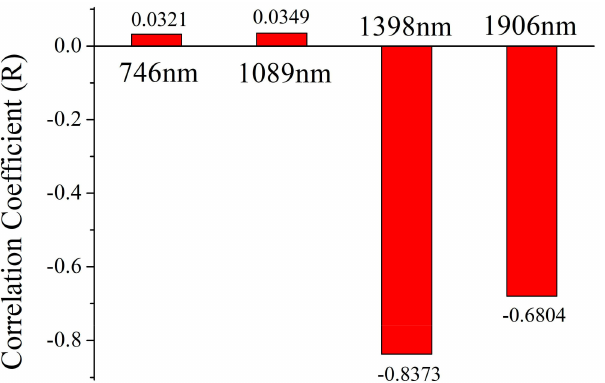
Figure 3. Correlation between the spectral information of the characteristic wavelengths of N + EWT and EWT parameter by using the synthetic dataset without